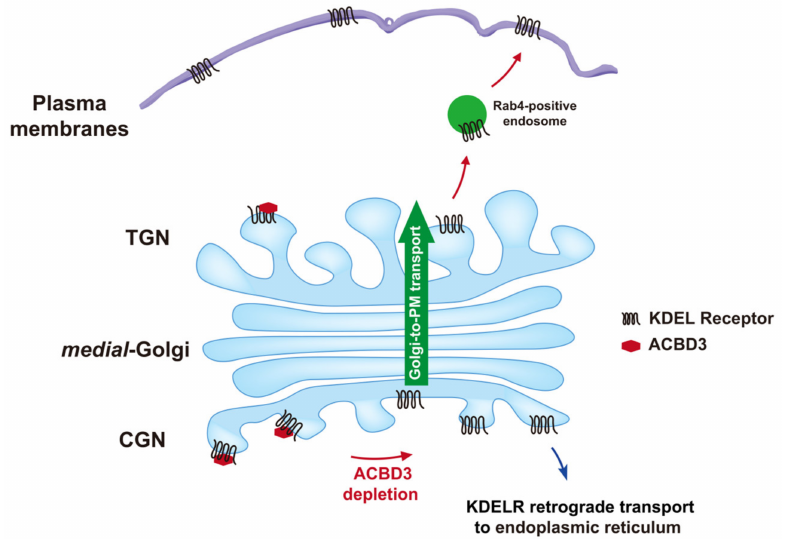
Figure 6. Schematic diagram depicting the proposed role of ACBD3 and Rab4A in controlling KDELR trafficking to the